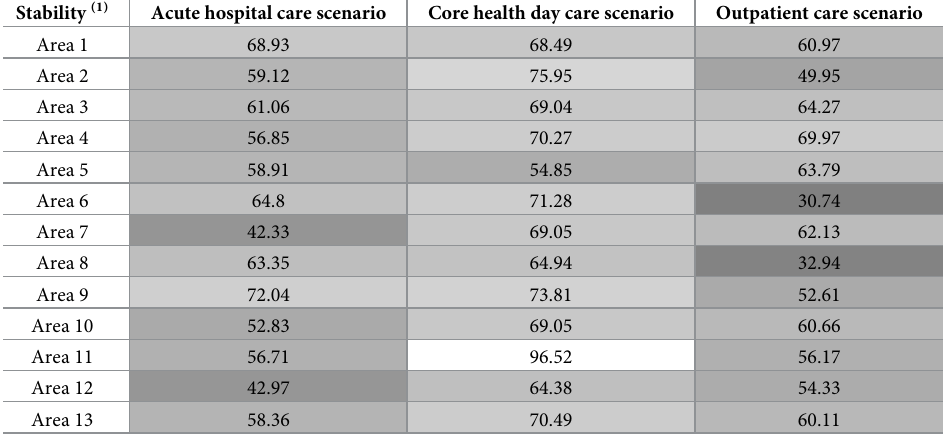
Table 4. Stability results. White indicates the best scores, and dark grey indicates the worst scores. Darker shading means lower stability. Stability